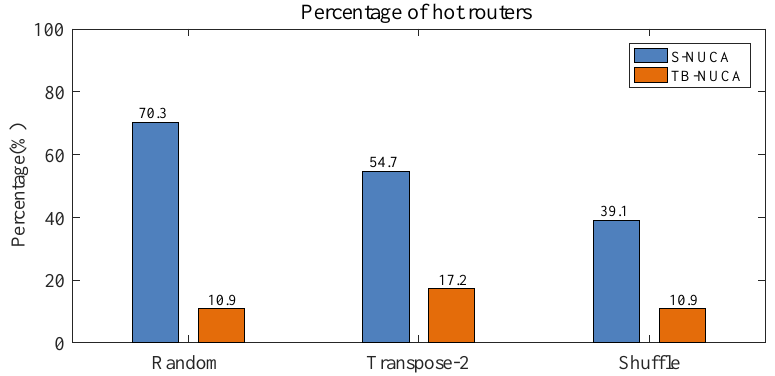
Figure 6. Percentage of hotspots for TB-NUCA and